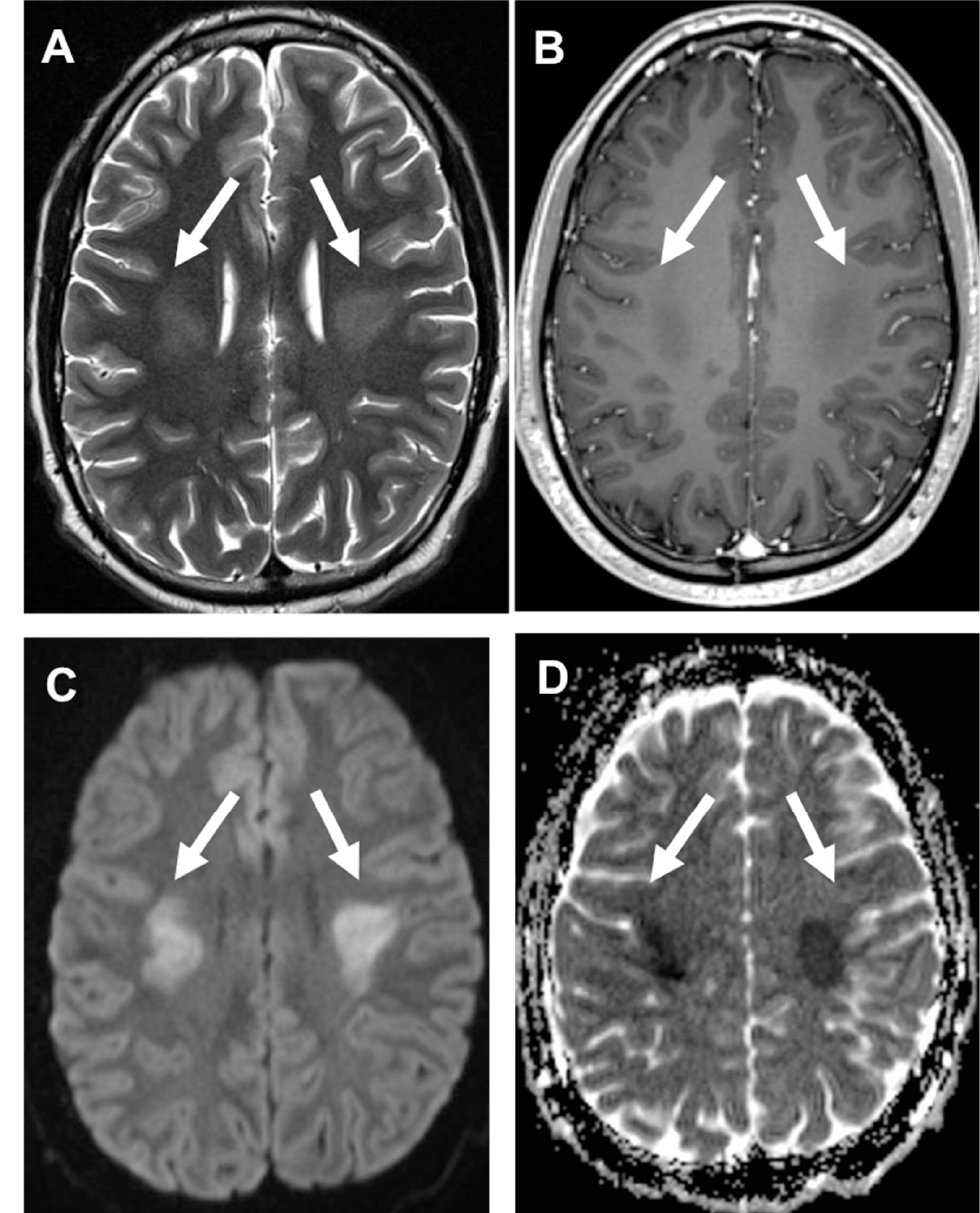
Figure 2. Acute Methotrexate-Induced Neurotoxicity during childhood acute lymphoblastic leukemia (ALL) therapy. MRI shows the characteristic pattern of acute MTX toxicity. Bilateral and symmetric white matter lesion areas of the corona radiata are defined by a high signal on T2 w (arrows, A ) and no contrast enhancement after gadolinium administration ( B ) associated with restricted diffusion on DWI ( C ) and ADC map ( D ).